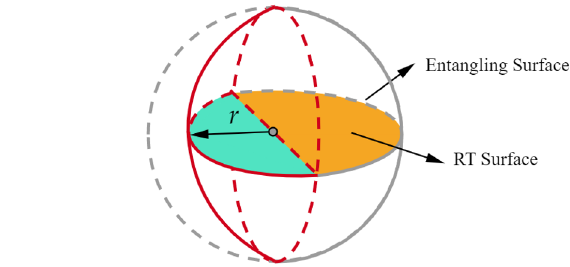
S CFT corresponds to the 2